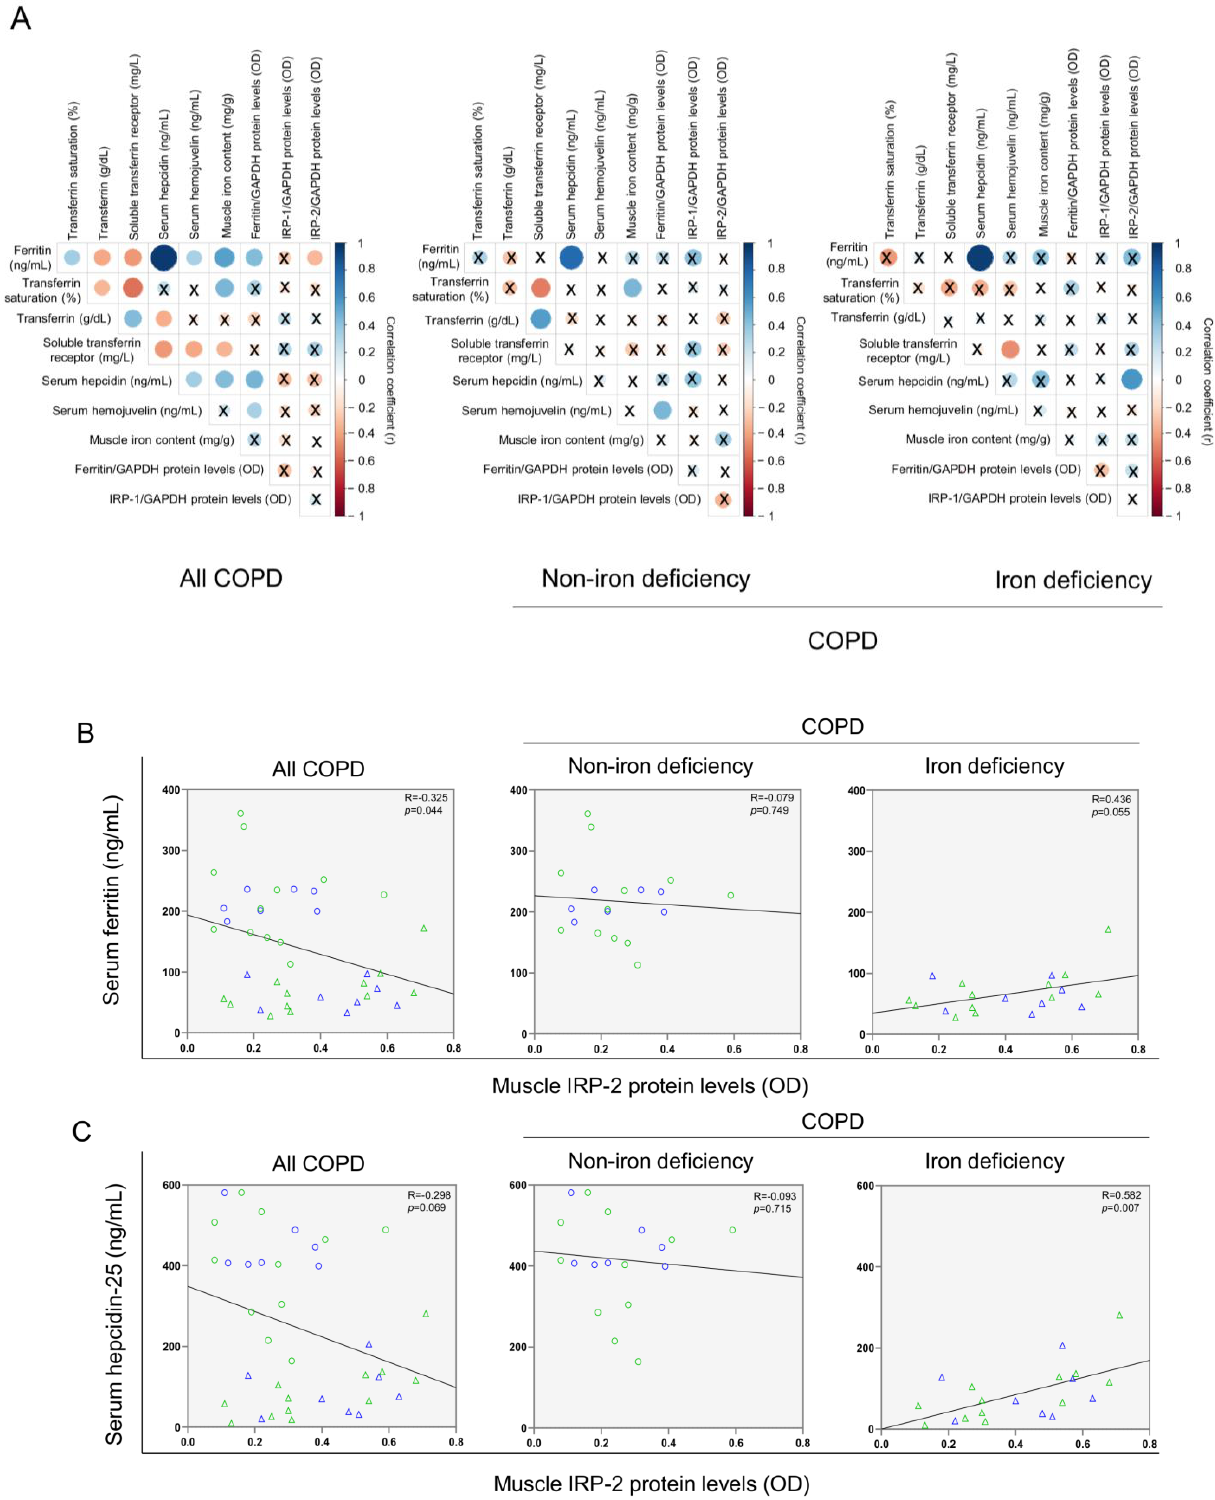
and IRP-2 ( G ) protein content as measured by optical densities in arbitrary units (OD, a.u.). In the graphs, the green color dots or triangles indicate male patients in either study group, while the blue color dots or triangles indicate female patients in the same groups. Definition of abbreviations: IRP, Iron regulatory protein; GAPDH, glyceraldehyde-3-phosphate dehydrogenase; MW, molecular weight; kDa, kilodalton. Adjusted p values for gender differences are shown in the graphs.